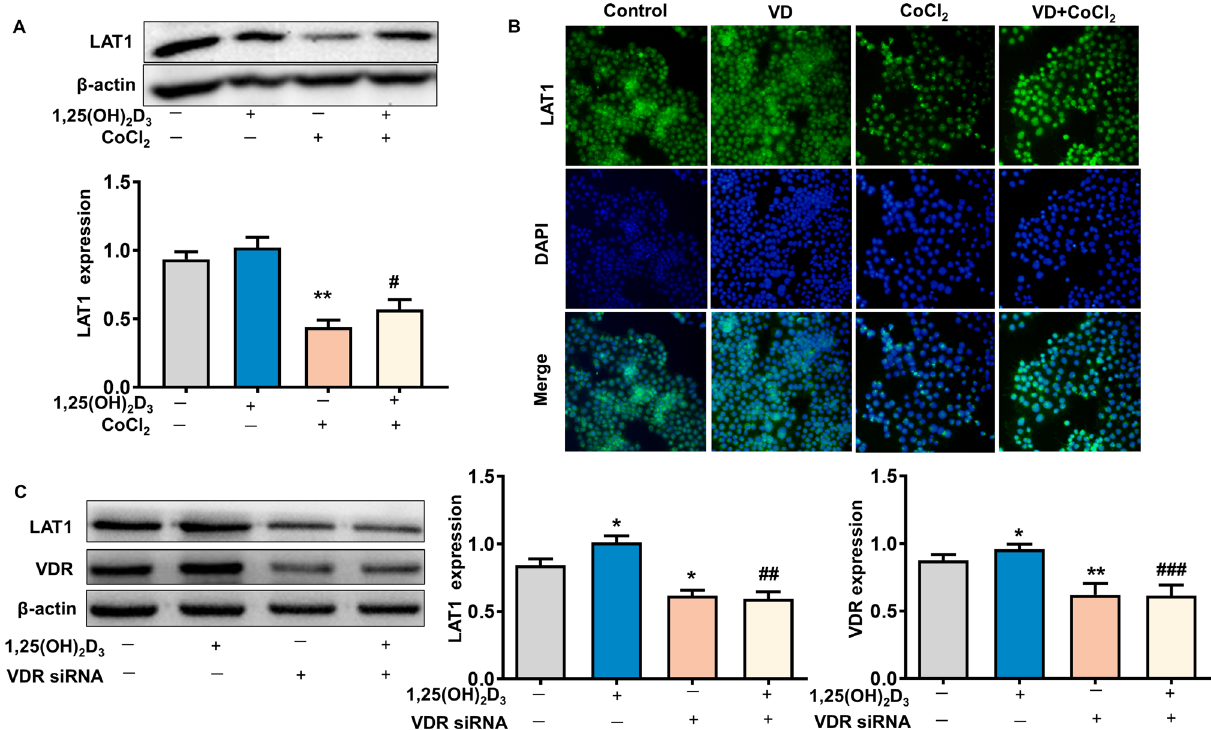
Figure 3. Effects of 1,25(OH) 2 D 3 on CoCl 2 -induced LAT1 expression in placental trophoblasts. ( A ) Protein expression of LAT1 detected by Western blot in HTR-8/SVneo trophoblast cells treated with CoCl 2 in the presence or absence of 1,25(OH) 2 D 3 . The decreased LAT1 expression induced by CoCl 2 was attenuated when cells were treated with 1,25(OH) 2 D 3 . The bar graphs show relative protein expression after being normalized by β-actin in each sample from six independent experiments. **P < 0.01, CoCl 2 treated vs control; # P < 0.05, 1,25(OH) 2 D 3 + CoCl 2 vs CoCl 2 alone. ( B ) Representative imaging of immunofluorescent staining of LAT1 in trophoblasts treated by CoCl 2 with or without 1,25(OH) 2 D 3 . Consistent with Western blot results, 1,25(OH) 2 D 3 could prevent CoCl 2 -induced decreased LAT1 expression in trophoblast cells. ( C ) Protein expression of VDR and LAT1 expression in trophoblasts treated with VDR siRNA in the presence or absence of 1,25(OH) 2 D 3 . Inhibition of VDR expression attenuates 1,25(OH) 2 D 3 -stimulated LAT1 expression in trophoblast cells. The bar graphs show relative VDR and LAT1 expression after being normalized by β-actin in each sample from six independent experiments, *P < 0.05, **P < 0.01, treated vs control; ## P < 0.01, ### P < 0.001, 1,25(OH) 2 D 3 + VDR siRNA vs 1,25(OH) 2 D 3